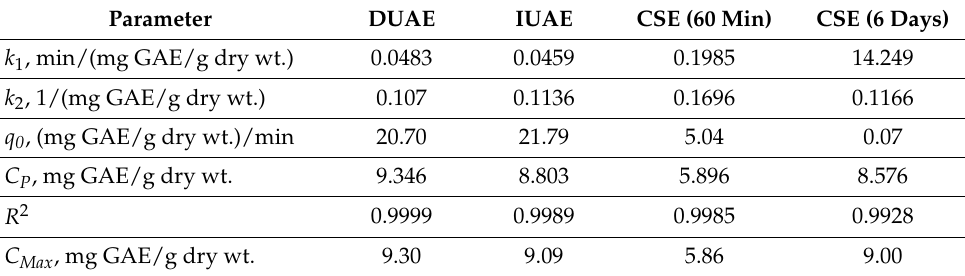
Table 1. Parameters obtained by fitting the Peleg model with experimental data shown in Figure 1. Parameter DUAE IUAE CSE (60 Min) CSE (6 Days) k 1 , min/(mg GAE/g dry wt.) 0.0483 0.0459 0.1985 14.249 k 2 , 1/(mg GAE/g dry wt.) 0.107 0.1136 0.1696 0.1166 q 0 , (mg GAE/g dry wt.)/min 20.70 21.79 5.04 0.07 C P , mg GAE/g dry wt. 9.346 8.803 5.896 8.576 R 2 0.9999 0.9989 0.9985 0.9928 C Max , mg GAE/g dry wt. 9.30 9.09 5.86